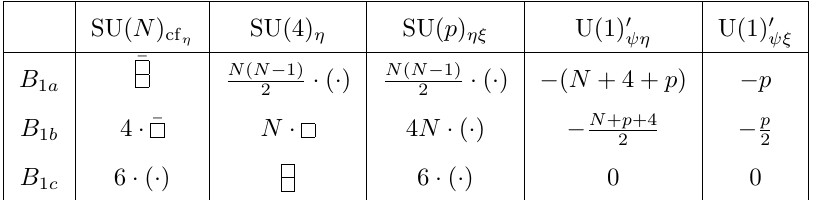
Table 9 . IR massless fermions in the BY model in the Higgs